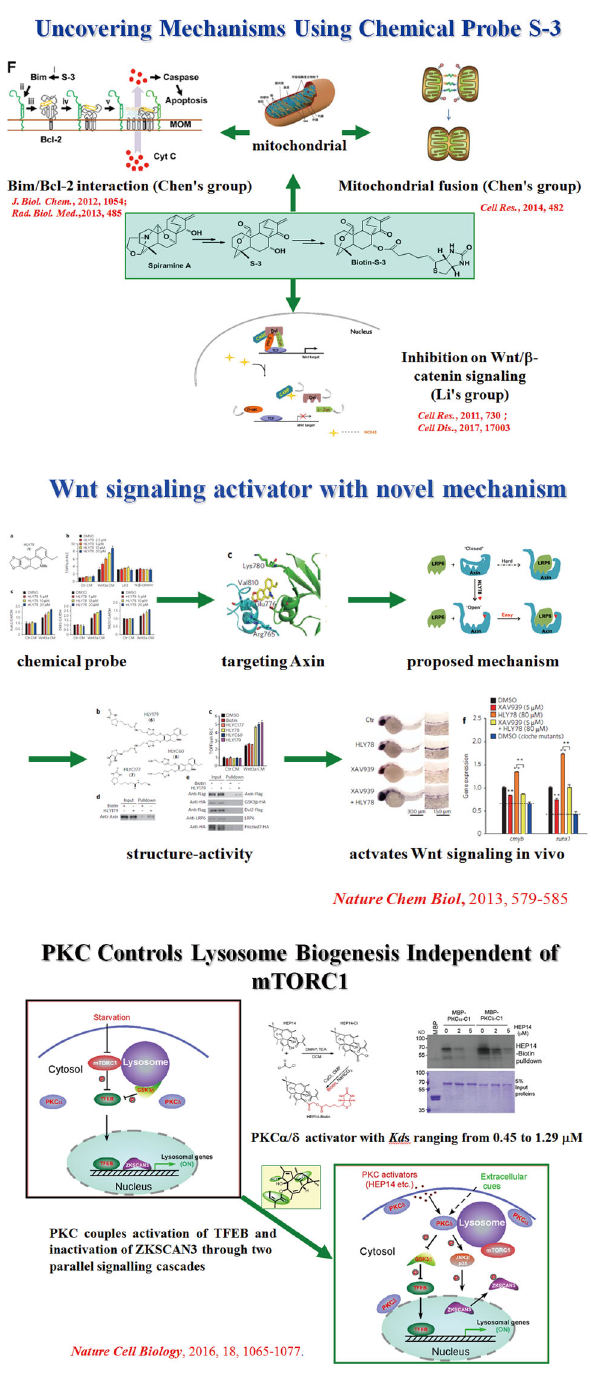
Fig. 4 Cooperative research of Prof. Hao on chemical biology of plant natural